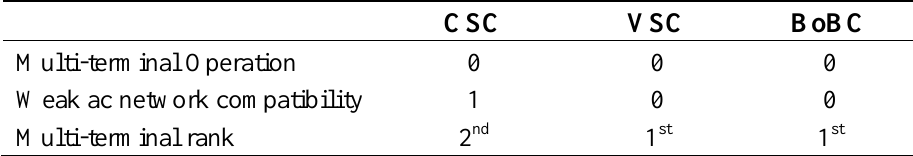
Table 8. Wind farm connection performance penalty